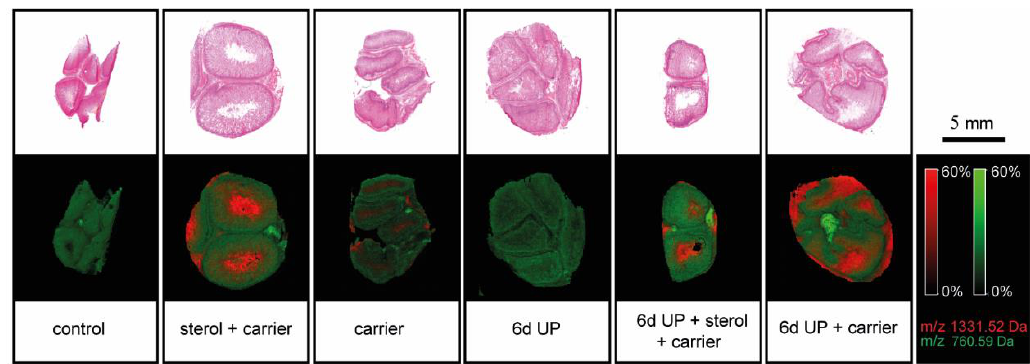
Figure 10. Presence of the carrier, indicated by m/z 1331.52 [M+Na]+, was detected in the intestinal lumen in the carrier, 6-d UP + carrier, sterol + carrier, and 6-d UP + sterol + carrier groups, but not in the control and 6-d UP groups: m/z 760.59 [M+H]+ was a homogenously distributed PC lipid present in the intestinal epithelial layer. Scale bar indicates 5 mm. Abbreviations: PCs, phosphocholines; UP, U. parvum